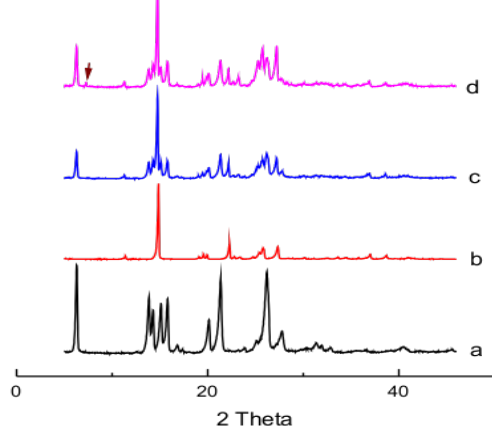
Fig. 2. The powder X-ray diffraction pattern of MFA (a), NIC (b), physical mixture of MFA-NIC (c), and cocrystal of MFA-NIC